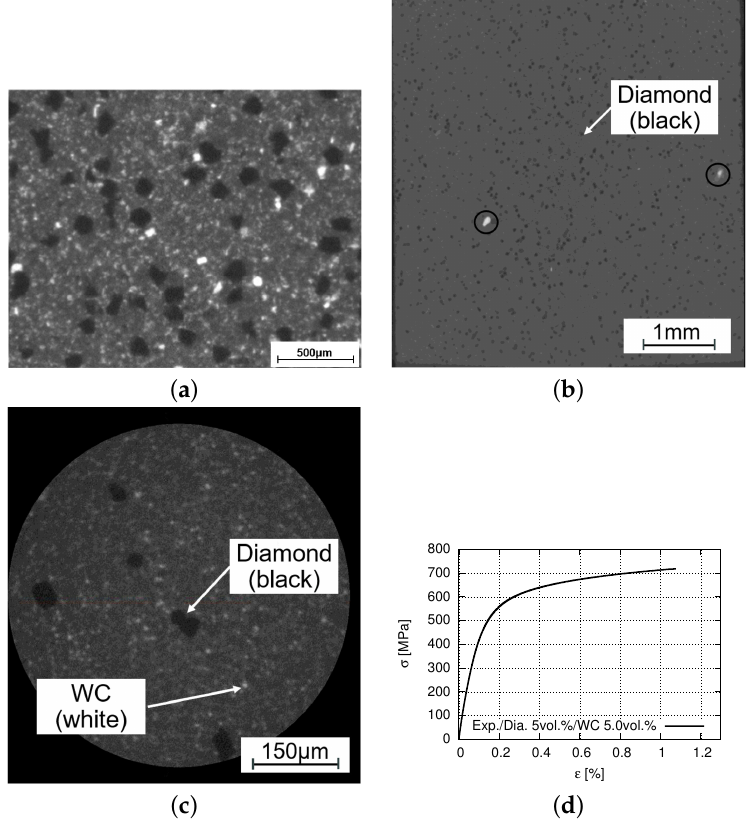
Figure 3. Real 2D microstructure cut-outs and stress-strain curve of Co/WC/diamond composites: ( a ) an SEM image [49] (type-I, ductile behavior); ( b ) one tomographic image with a pixel resolution of 5.2508 µ m/pixel (scan-A, type-II, quasi-brittle behavior), where two big WC particles are marked in circles (mean size 3–5 µ m); ( c ) one tomographic image with a pixel resolution of 0.6715 µ m/pixel (scan-B, type-II, quasi-brittle behavior); ( d ) a global tensile stress-strain curve (type-II, quasi-brittle